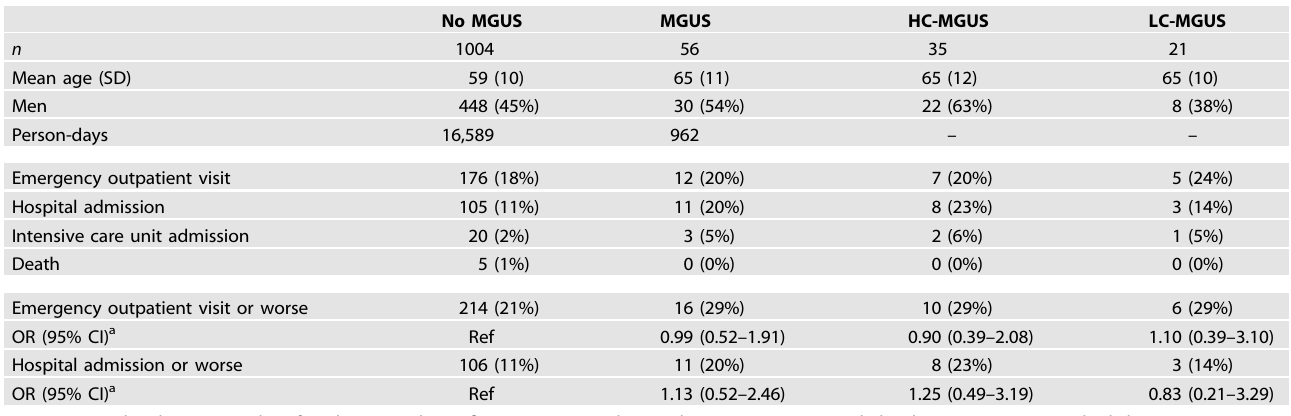
Table 2. Baseline characteristics of SARS-CoV-2-positive participants and the association between MGUS and severity of COVID-19.